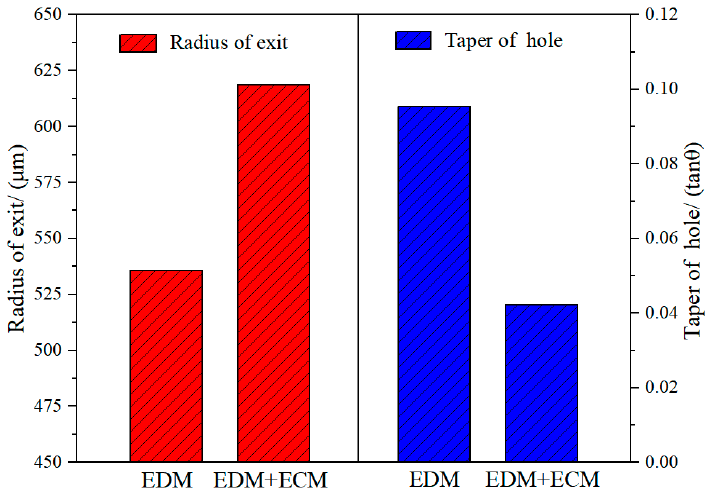
Figure 8. Geometric accuracy of holes machined by two different methods.